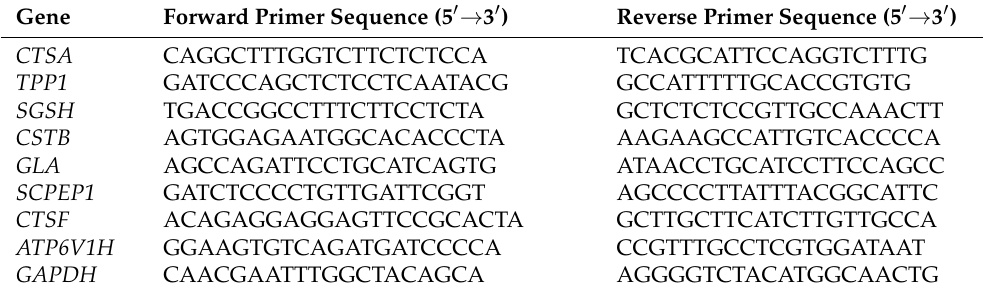
Table 1. Primer sequences for